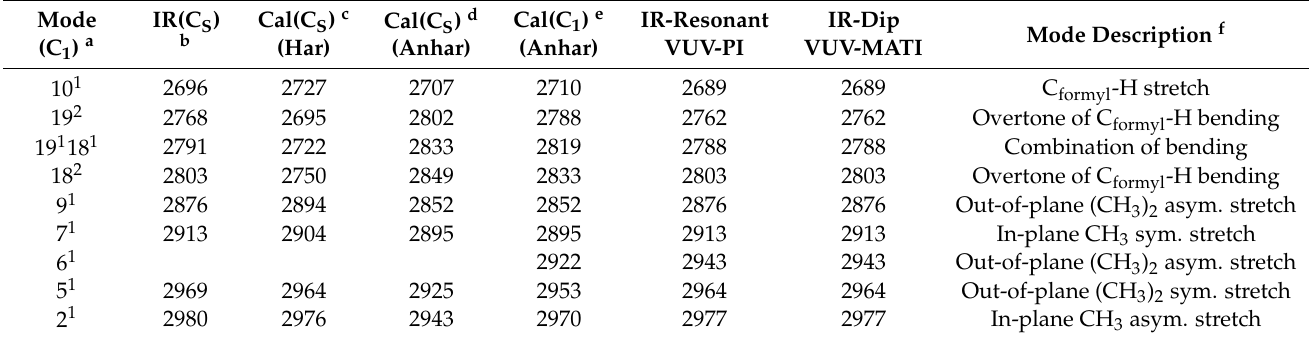
Table 3. Vibrational assignment of pivaldehyde in high-frequency region (cm − 1 ) of S 0 state.